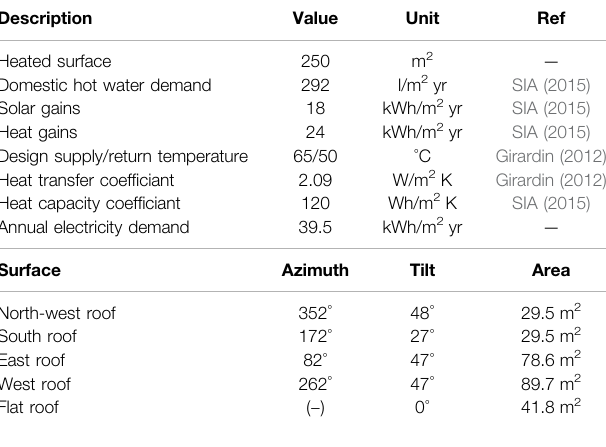
TABLE 1 | Building parameters for a typical single – family house with large available roof